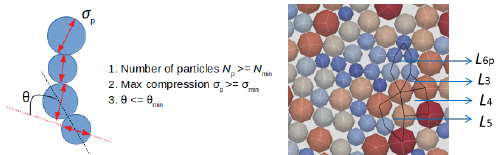
Figure 3. Force chain (left) and grain loop